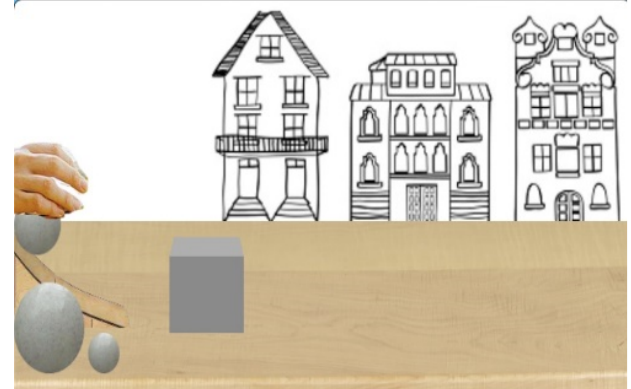
Figure 1. The hand placing the ball on the ramp.